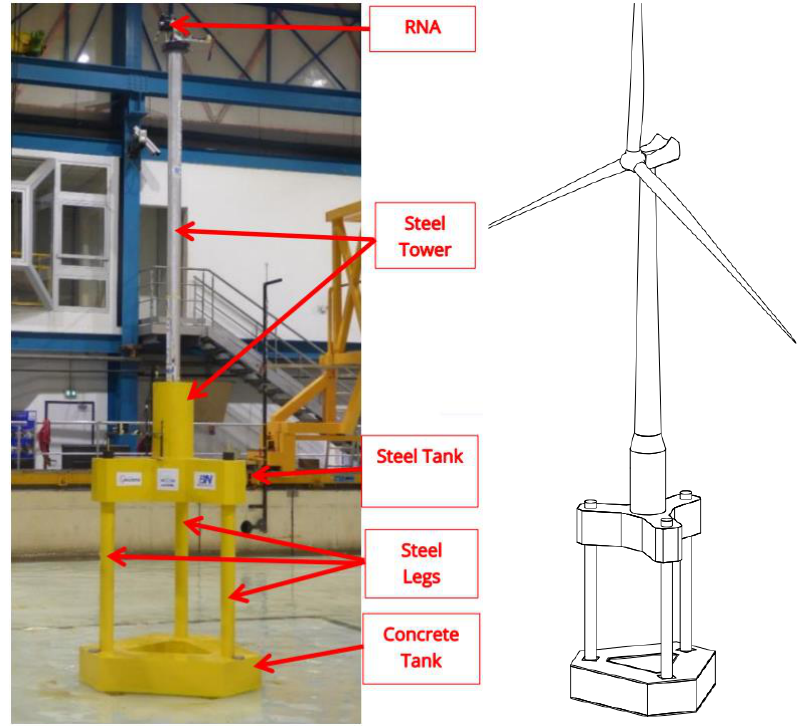
Figure 1. Experimental model of the WIND-bos platform (left) and its view in perspective (right).